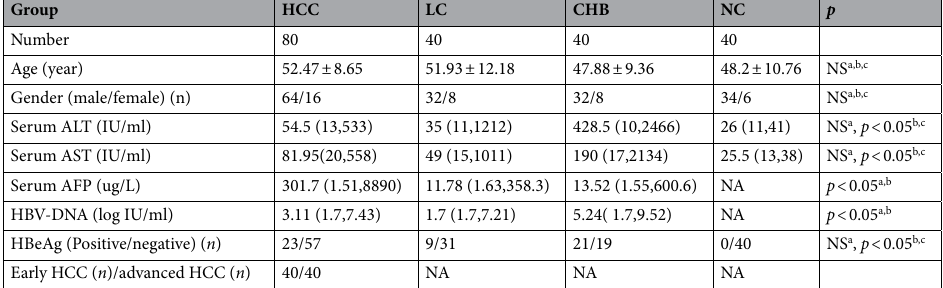
Table 2. Demographic and clinical characteristics of the validation cohort. The quantitative variables of the normal distribution were represented as mean ± standard deviation (SD), the student’s-t test was used for comparison between the two groups, and analysis of variance was used for comparison between multiple groups. The quantitative variables of the non-normal distribution were represented by median (range), the Mann–Whitney U test was used between two groups. a HCC group versus LC group; b HCC group versus CHB group; c HCC group versus NC group. Abbreviations: NC normal control, CHB chronic hepatitis B, LC liver cirrhosis, HCC hepatocellular carcinoma, ALT alanine aminotransferase, AFP α-fetoprotein, NA Not Available, NS no